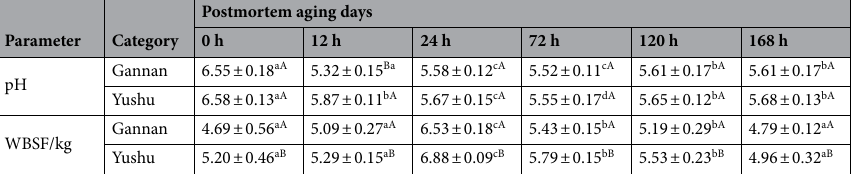
Down-regulation of protein quantity